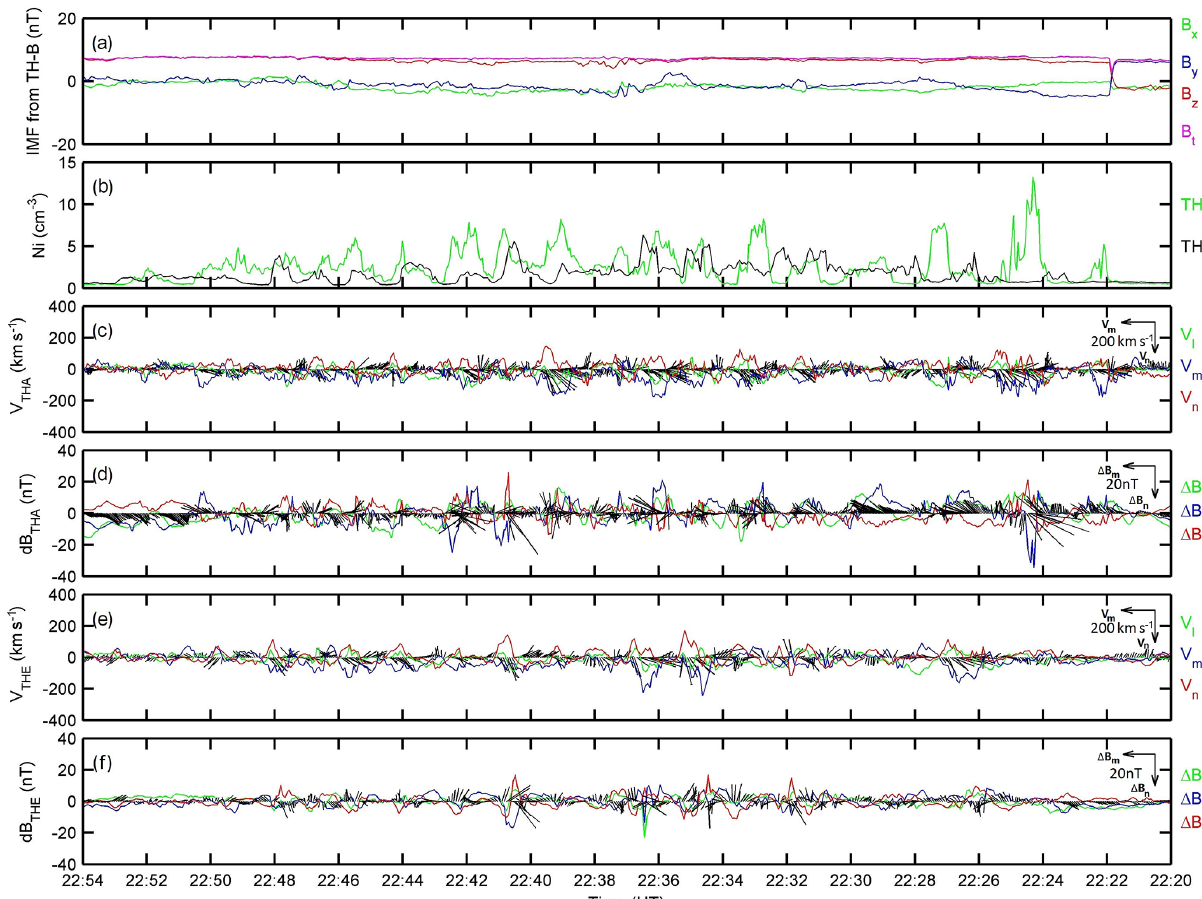
Figure 3. The observed plasma rotations and perturbations of the magnetic field because of the formation of K–H vortices. Panel (a) is the IMF monitored by TH-B near the lunar orbit, with a time lag of 10min from the subsolar magnetopause to TH-B; panel (b) is the ion densities from TH-A in green and from TH-E in black; panels (c) and (e) are the ion bulk velocities from TH-A and TH-E, respectively, expressed in averaged local magnetopause coordinates LMN, deduced from the magnetopause model (Shue et al., 1998); panels (d) and (f) are the magnetic field perturbations, (cid:49)B = B − B mean , from TH-A and TH-E, respectively, expressed in LMN. Note that the time begins from the right and passes to the left, so that the M component orients leftward and the N component orients downward in the